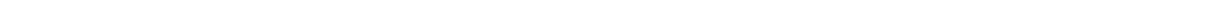
Fig. 1 Attention enhances different target populations before and after a saccade. a Cartoon demonstrating that different neurons (retinotopically) represent an attended stimulus across a saccade. Stimulus X is foveated before the saccade and stimulus Z after the saccade. The attended stimulus Y falls in the RF of neurons representing retinal location a before the saccade and in the RF of neurons representing retinal location b after the saccade. b Two rhesus monkeys were trained to covertly attend to one of four moving RDPs (the target) while also making a visually guided saccade if the fi xation point (FP) jumped to a new location (after 673 ms). An initial spatial cue marked the target location on each trial. A different RDP appeared in the RF before and after the saccade. In Experiment 1, after the saccade, the stimulus in the RF was always a distractor, while before the saccade, either a target or a distractor appeared in the neuron ’ s RF; the situation was reversed for Experiment 2. The target change occurred between 263 and 1973 ms after RDP onset. c Population average peri-stimulus time histograms (PSTHs) from 84 neurons in Experiment 1, aligned to saccade offset. Before the saccade, neurons respond more strongly to a target stimulus (cyan curve) compared to a distractor stimulus (magenta curve). PSTHs constructed by fi ltering the spike-trains with a truncated Gaussian window (15 ms standard deviation, 100 ms fi lter width) stepping every 1 ms (see Methods). Inset rectangles: cue location for the two conditions. Left to right: fi rst dashed vertical line — mean time of RDP onset, second dashed vertical line — mean time of fi xation point jump, dotted vertical line — mean time of saccade onset. The early response before RDP onset in the attend-in condition (cyan curve) is the cue response. Data are pooled from both monkeys. d PSTHs for Experiment 2; 84 neurons. After the saccade, neurons respond more strongly to a target stimulus (blue curve) compared to a distractor stimulus (red